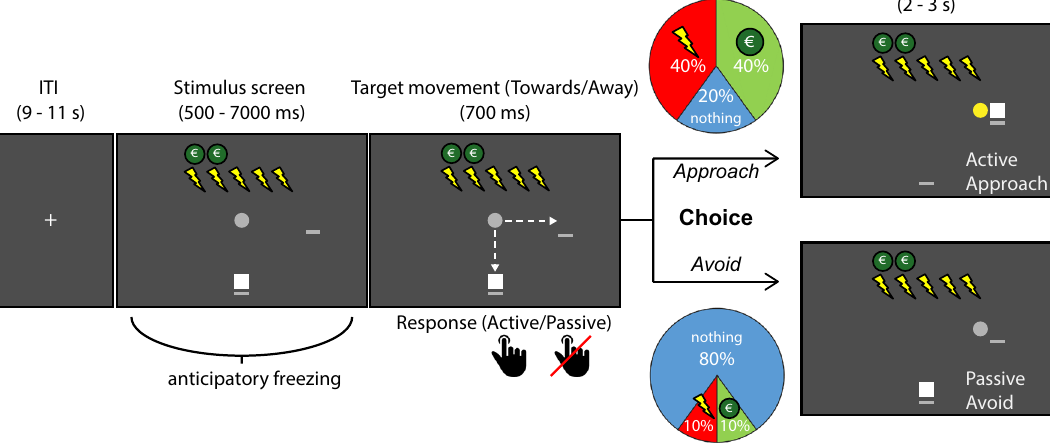
Figure 1. Timeline of an example trial in the Passive-active Approach–avoidance Task (PAT). After presentation of the trial-specific potential money and shock amounts (in this example 5 shocks and 2 Euro), the participant (white square) is asked to approach or avoid the target (gray circle) as it gradually moves either toward or away from the player (respectively passive vs. active action context, shown here = active). Depending on the action context, participants could give both passive and active approach–avoidance responses by either pressing a button (active) or not pressing the button (passive) during the target movement window. At the end of the trial the participant probabilistically received either shocks, money, or no outcome. Approach was associated with a high chance of receiving the shocks (40%) or the money (40%), and small chance of receiving nothing (20%), while avoid responses led to a high chance of receiving nothing (80%) and a low chance of receiving either the money (10%) or shocks (10%; see colored pie charts). After the target movement, the outcome of the trial was also indicated by a change of the target color into either green (money) or yellow (shocks), or no change (no outcome), and shocks were paid out immediately during that color change. Note: The dashed arrow lines were not present in the actual experiment.